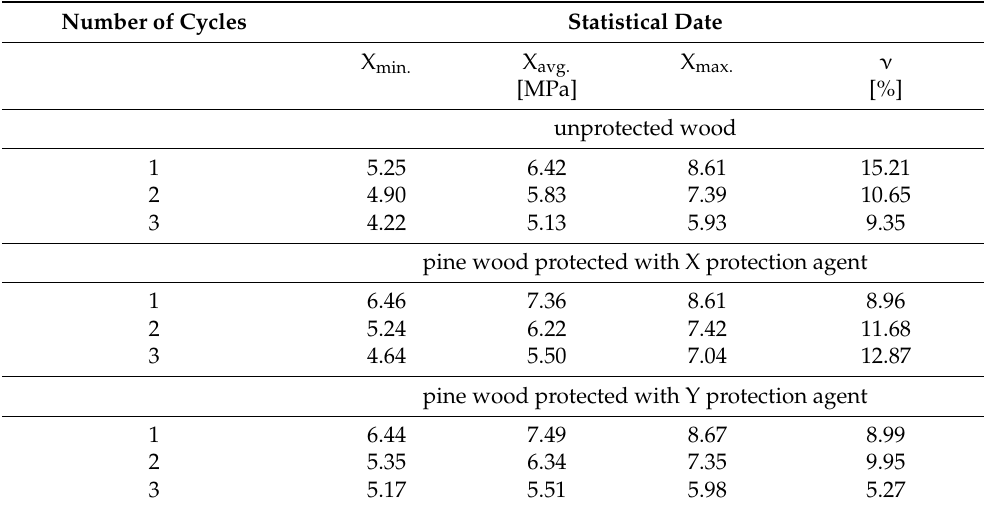
Table 6. Results of aging tests of glue lines from pine wood joints after D7 aging tests acc. to the PN-EN ISO 9142 standard [46].